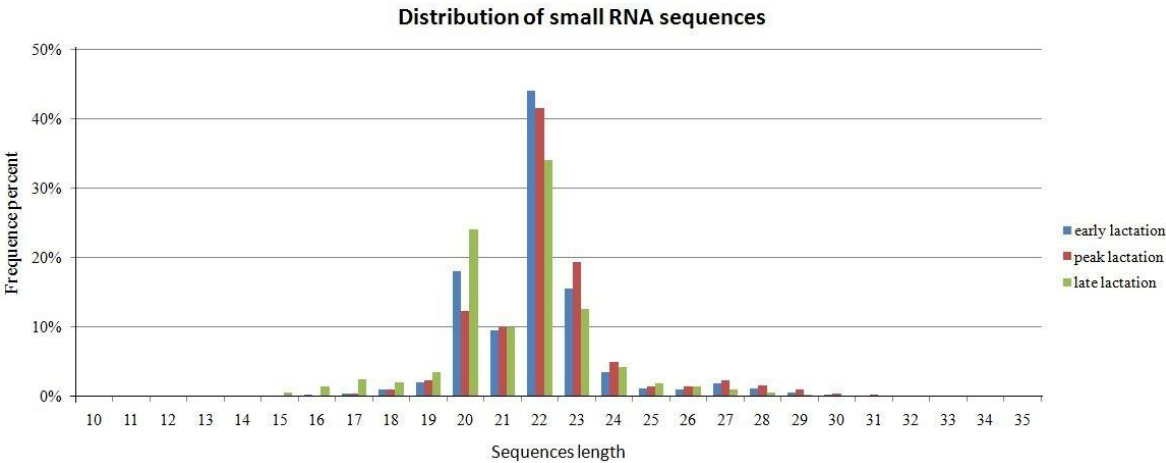
Figure 1. Distribution of sequence reads in three small RNA libraries. Distribution of the various lengths of the small RNA sequences in three libraries, the most of reads are 20, 22 and 23 nt in length, majority of small RNA sequences were primarily distributed in 19 to 24